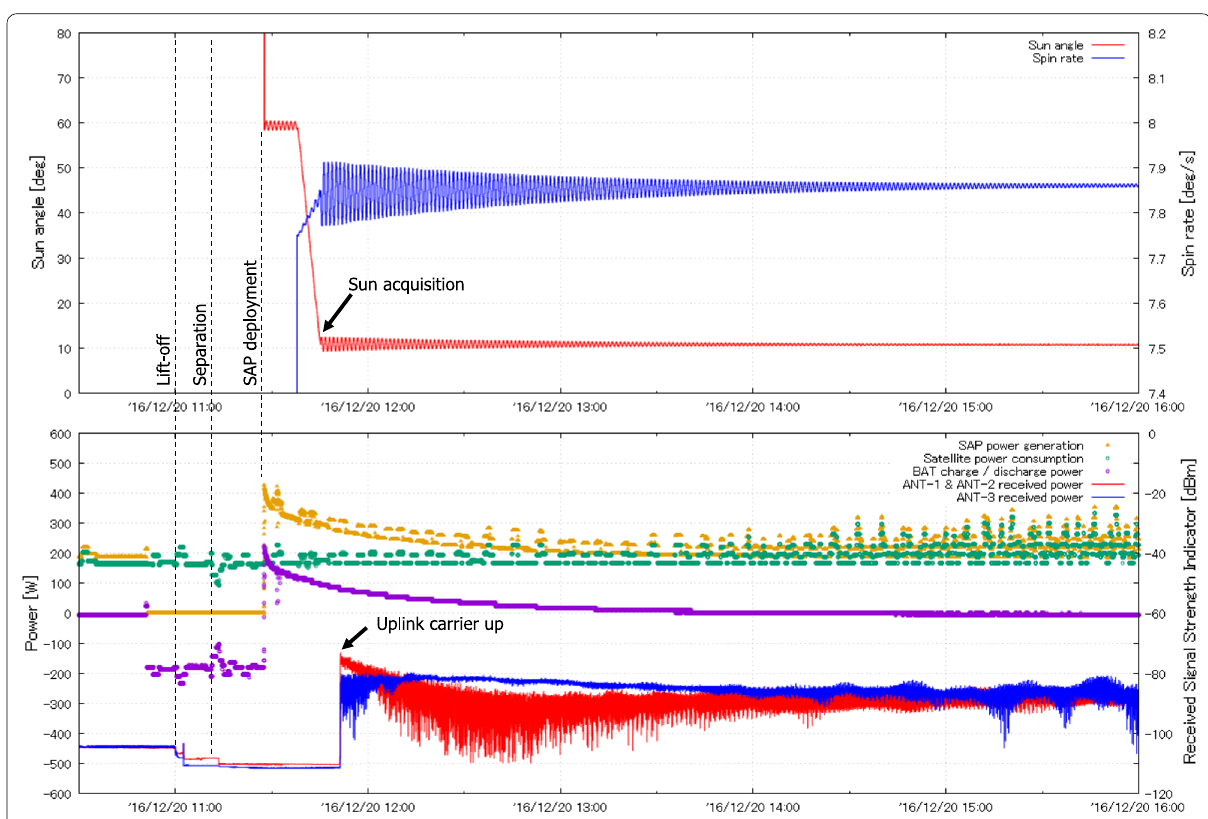
Fig. 13 Flight data from the attitude, power, and communication subsystems during the launch and early orbit phases